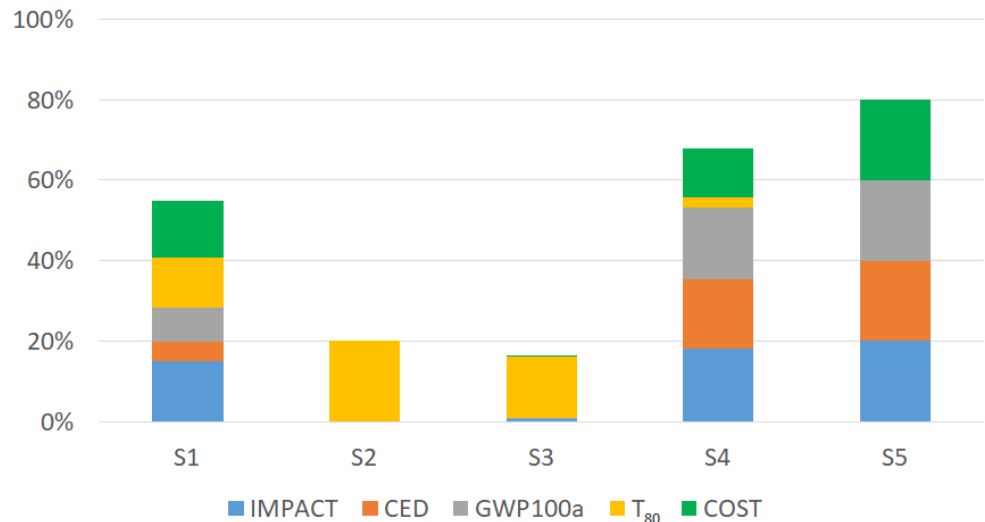
Figure 5. The normalized WSM indicator for the analyzed scenarios S1 – S5.